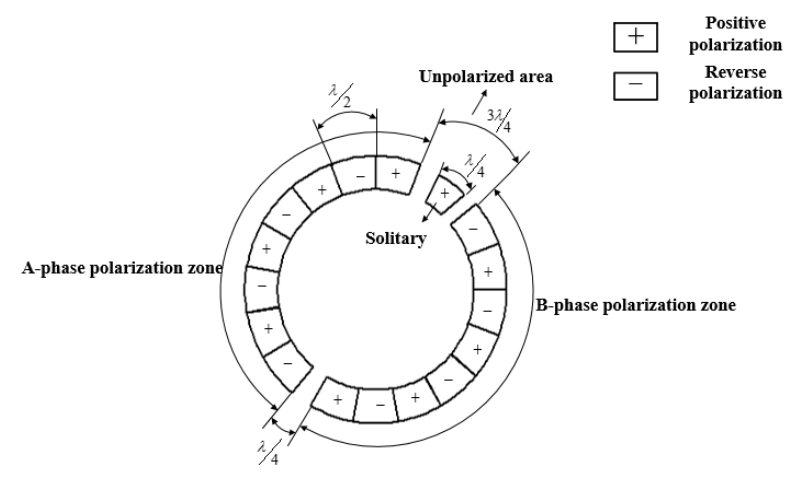
Figure 2. Schematic diagram of piezoelectric ceramic sheet.